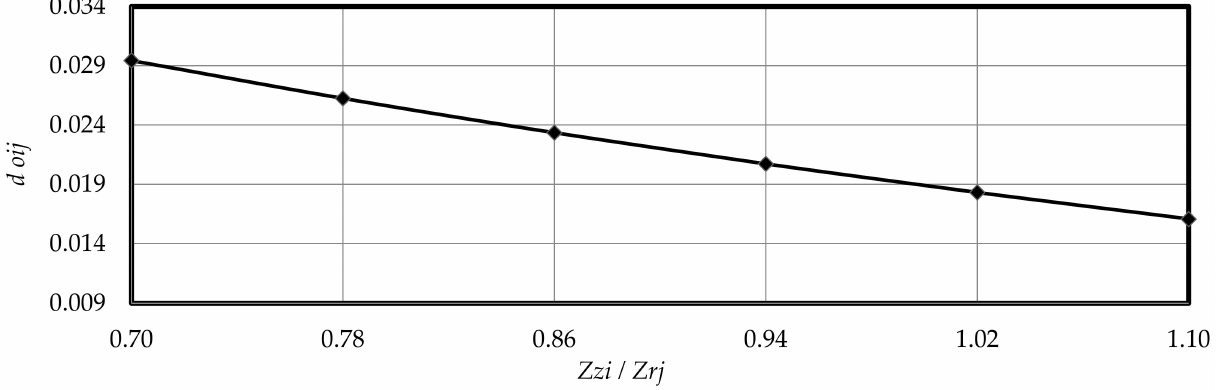
Figure 7. Graph of the change in trip distribution function of urban employers of service enterprises depending on the ratio of one square meter cost of housing in the zone of residence to the cost of one square meter of housing in the zone of application of labor.